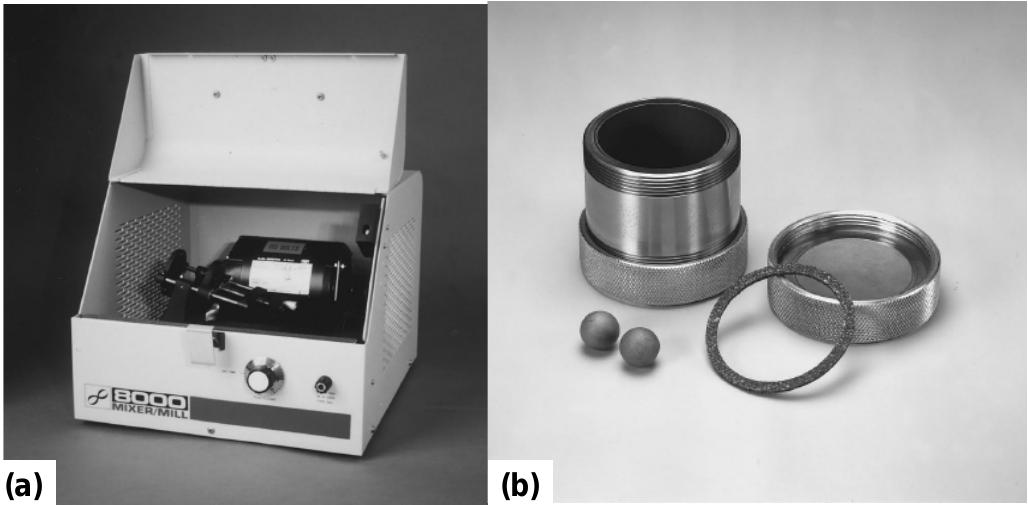
Scheme 24. MBH reaction obtained by high speed ball milling. CHO OMeO DABCO + R R= NO 2 , Br, Cl, H, OMe